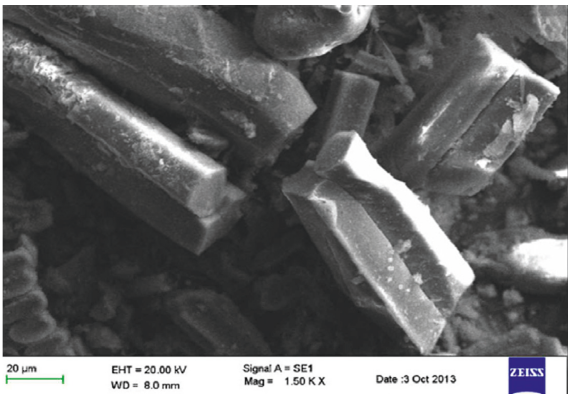
Figure 13: SEM structure of SCBA